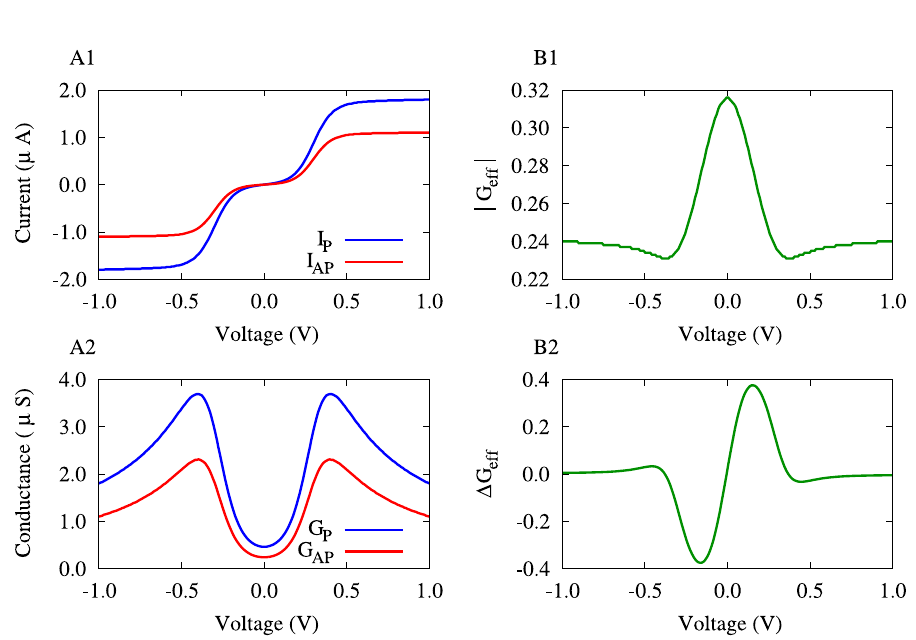
Fig 4. Voltage-dependent plasticity of effective conductance in the PDT-based MTJ. ( A1 ) Current-voltage characteristics for parallel and anti-parallel configurations. ( A2 ) The corresponding tunneling conductance derived from the spin-polarized current for parallel and anti-parallel states. ( B1 ) The effective tunneling conductance introduced by Eq (13). ( B2 ) The derivative of the effective conductance is calculated to provide a measure of its change which is reminiscent of the classical asymmetric STDP profile. The molecule-electrode coupling strength was γ = 0.1.